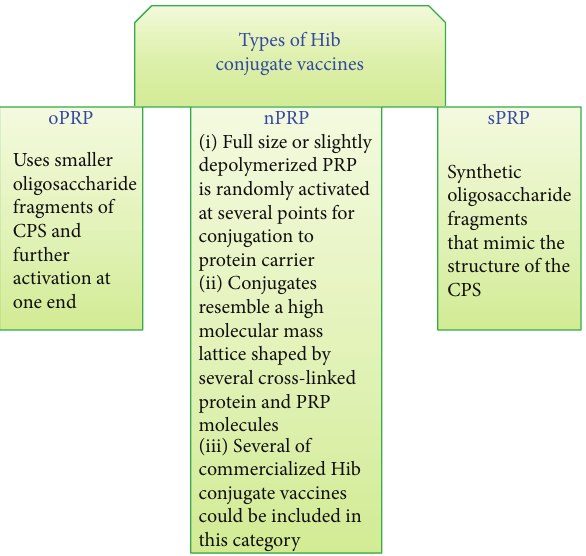
Figure 2: Schematic diagram summarizing the types of currently used Hib vaccines according to the type of PRP (nPRP-native PRP, oPRP-oligosaccharide PRP, and sPRP-synthetic